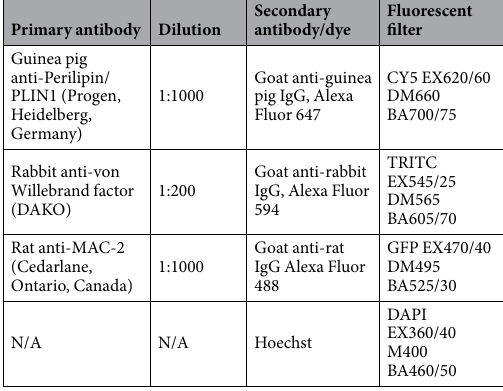
Table 1. Materials used for